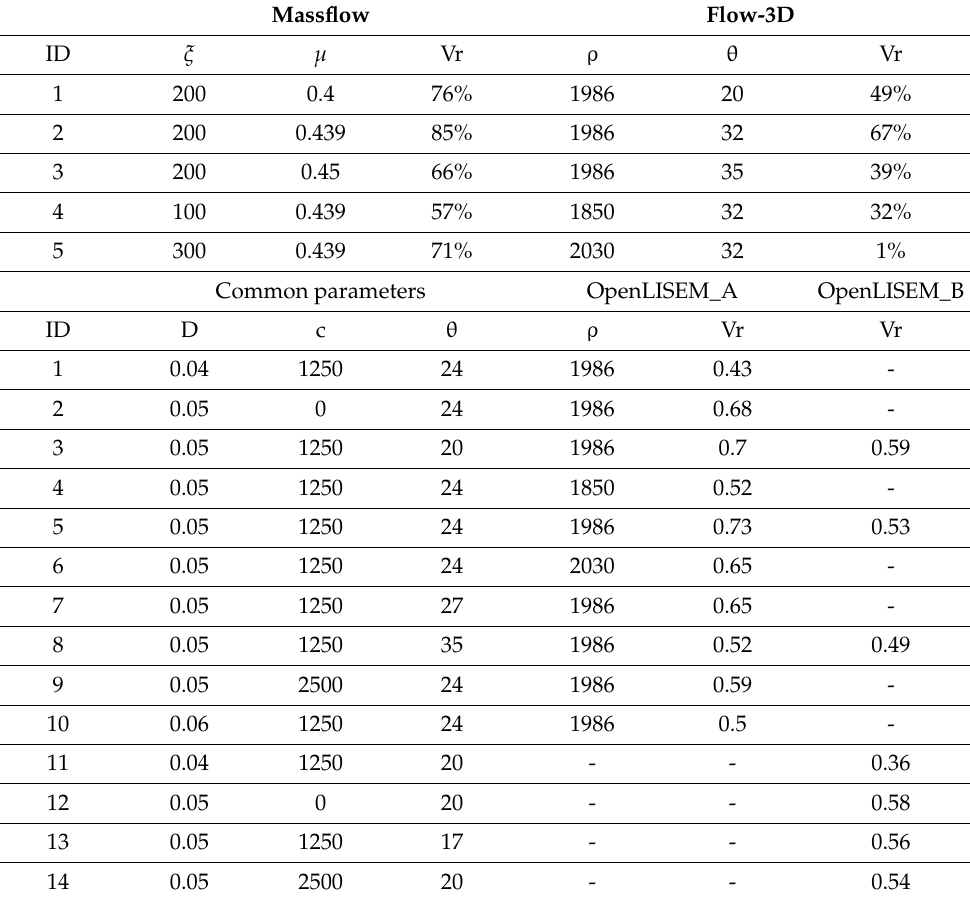
Table 3. Analysis of the final deposition volume dependence in the debris fan area on the various parameters. When a variable is analyzed, the other parameters are the same as those in Table 1. Vr means the simulated debris fan volume to measured debris fan